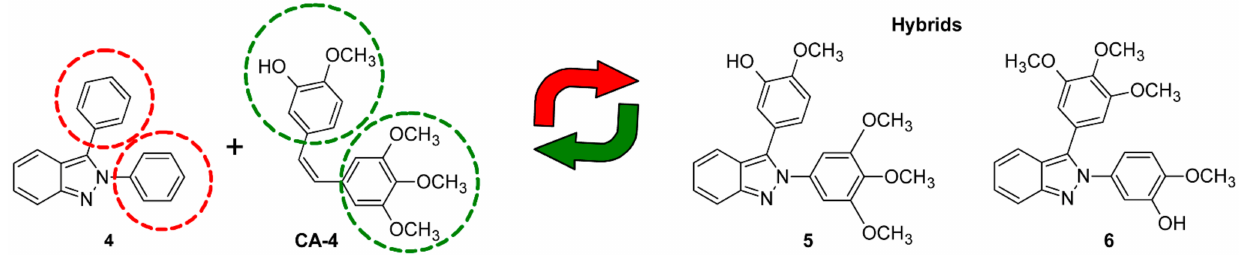
Figure 1. Molecular design of hybrid